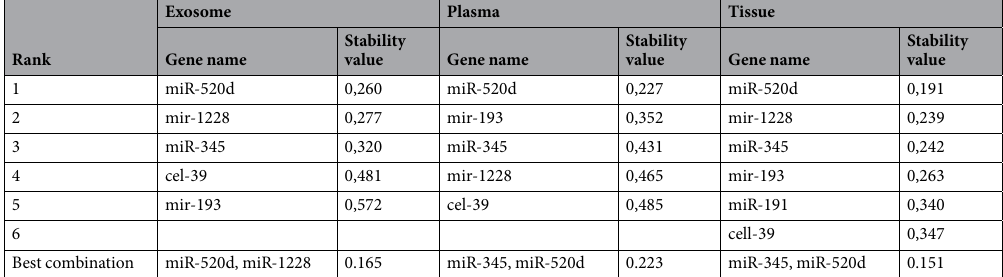
Table 3. Ranking of candidate reference miRNAs using NormFinder